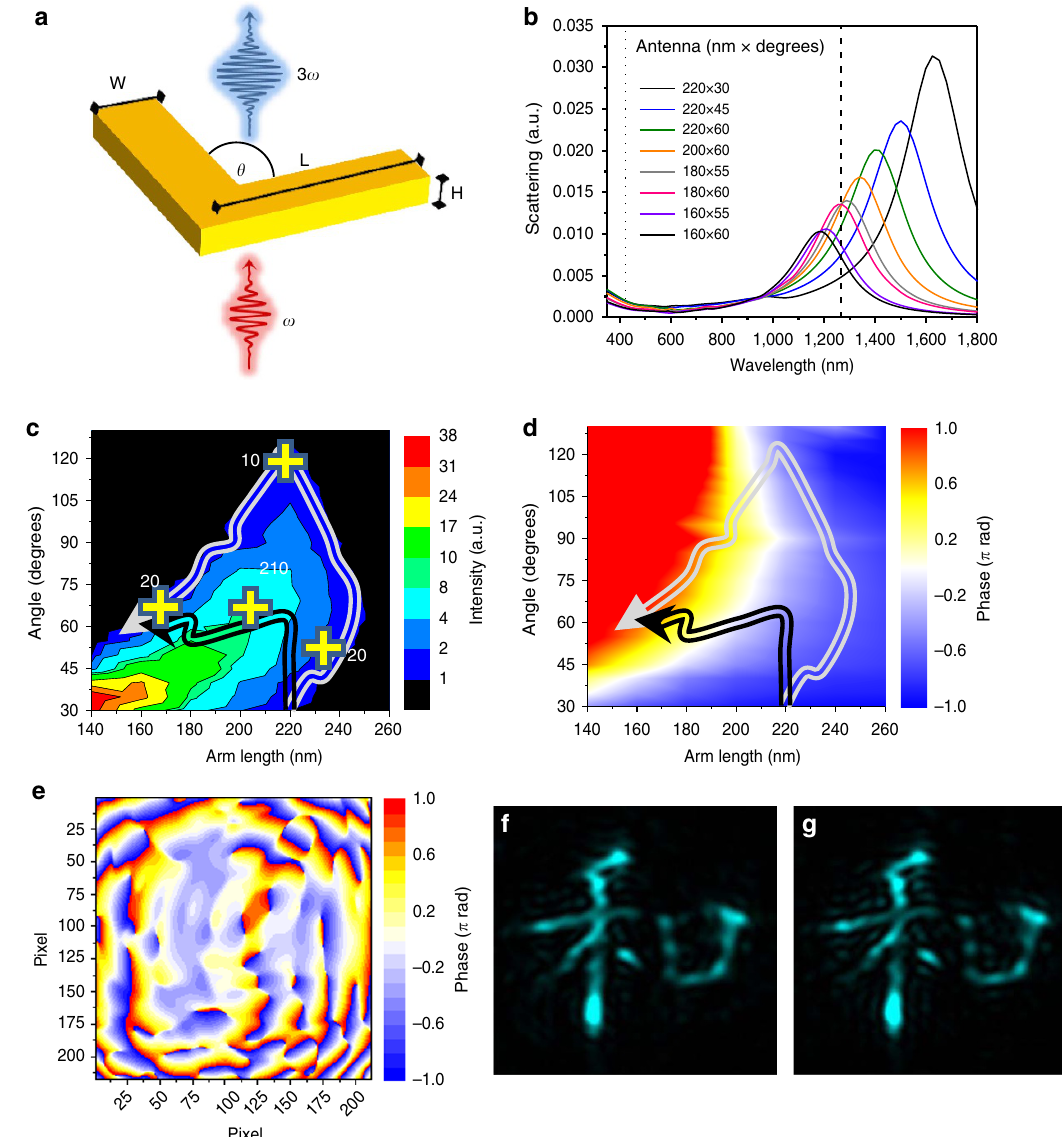
Figure 2 | Design of phase-controlled nonlinear nanoantennas. ( a ) Dimensions of the V-shaped gold antennas for local control of the phase of the nonlinearity. The free parameters are the arm length L and the angle y between the arms. H ¼ 30nm and W ¼ 40nm are constant for all antennas. ( b ) Representative linear scattering spectra of some of the antennas ( L (cid:2) y ), the input light was polarized along the bisecting axis of the V-shaped antennas. The dashed and dotted lines indicate the free-space wavelengths of the fundamental ( l F ¼ 1,266nm) and third harmonic ( l F ¼ 422nm) beams respectively. Intensity ( c ) and phase ( d ) map of the third harmonic signal with two possible paths: the white path with minimal amplitude variations and the black path, with larger amplitude variations but with much larger extinction for the ‘wrong’ polarization (see Supplementary Note 2). The ( þ ) crosses indicate the extinction ratio of third harmonic signal for two orthogonal polarization modes. ( e ) Depicts the calculated phase distribution on a sample hologram (see below) and the corresponding numerical reconstruction for antennas chosen along the black path ( f ) for a distance of 750 m m. ( g ) Shows the same hologram but calculated for a constant amplitude with hardly any differences the resonant nature of w 3 ð Þ . Figure 2 provides the information The maps of amplitude and phase of the THG generated at eff about the antennas and their phase control. Figure 2a depicts the 3 o ¼ 422 nm , calculated by nonlinear FDTD, are presented in antenna and the dimensions of the relevant parameters Fig. 2c,d. We used a realistic range of parameter that is enough to (arm length and angle); Fig. 2b depicts finite differences time generate a 2 p relative phase shift when both the fundamental and domain (FDTD) calculations of the linear plasmonic resonance the third harmonic beams are of the same polarization. A path along which to design the phase elements is a guide for the choice transmission intensity for various combinations of arm lengths and angles. It is clearly seen that the resonance peak moves to of parameters. Two such paths are depicted in Fig. 2c,d. longer wavelengths for longer arm length and smaller angles. The white path provides small variation of the intensity, but at To generate our phase holograms, which follow a working the same time, low extinction for the perpendicular polarization, and low field enhancement of THG. The black path, on the principle similar to the earliest kinoform-type holograms 37 , we need phase information for each element at the THG wavelength. other hand, provides the same 2 p phase range, much higher field